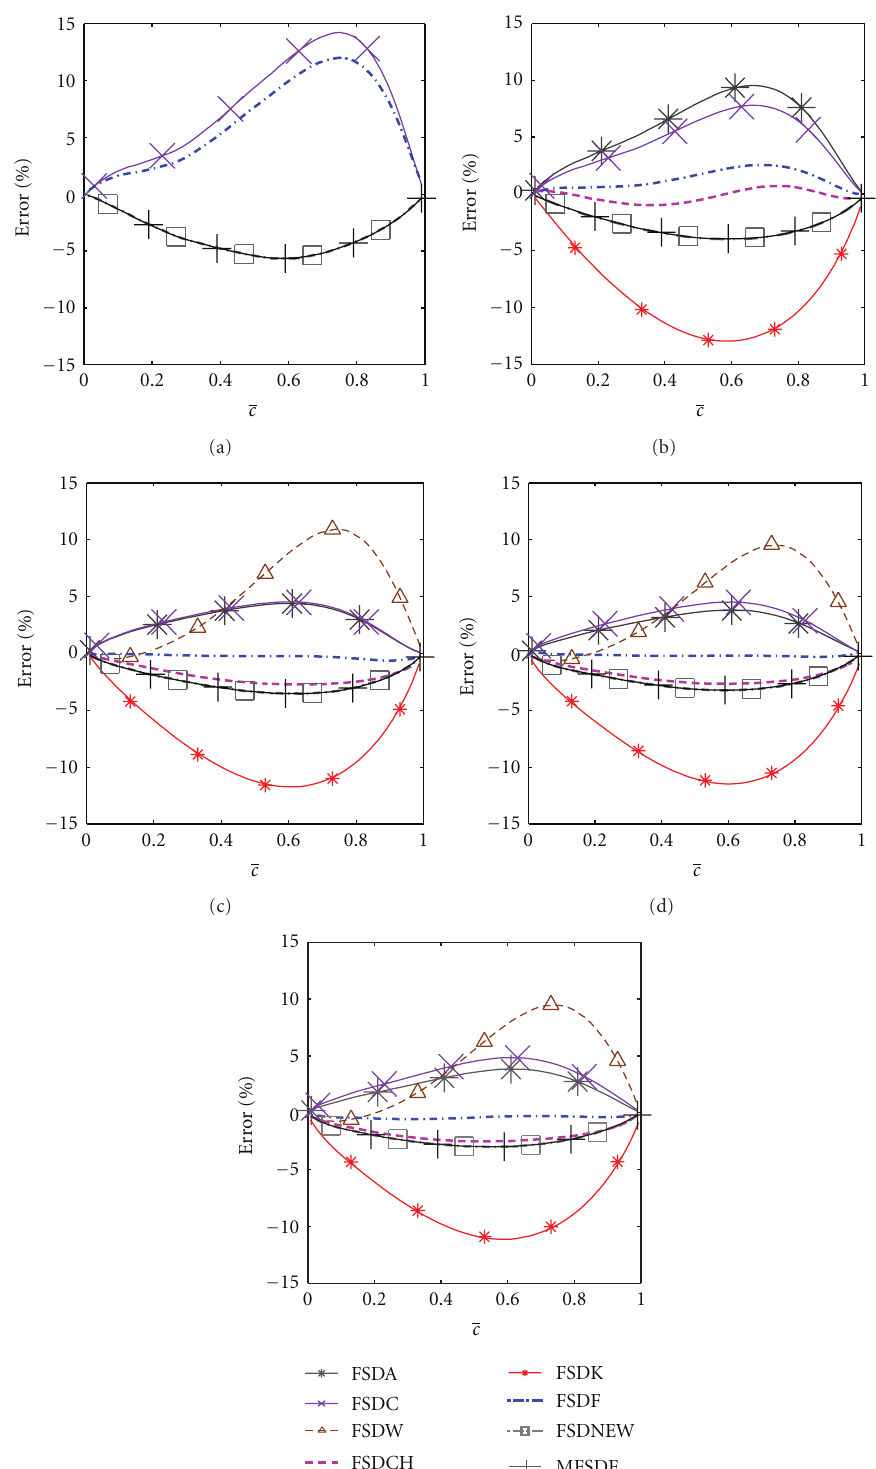
Figure 6: Variation of percentage error (17) on c across the flame brush for Δ = 8 Δ m = 0 . 8 δ th according to FSDA, FSDC, FSDW, FSDCH, FSDK, FSDF, FSDNEW, and MFSDF predictions for (a–e) cases